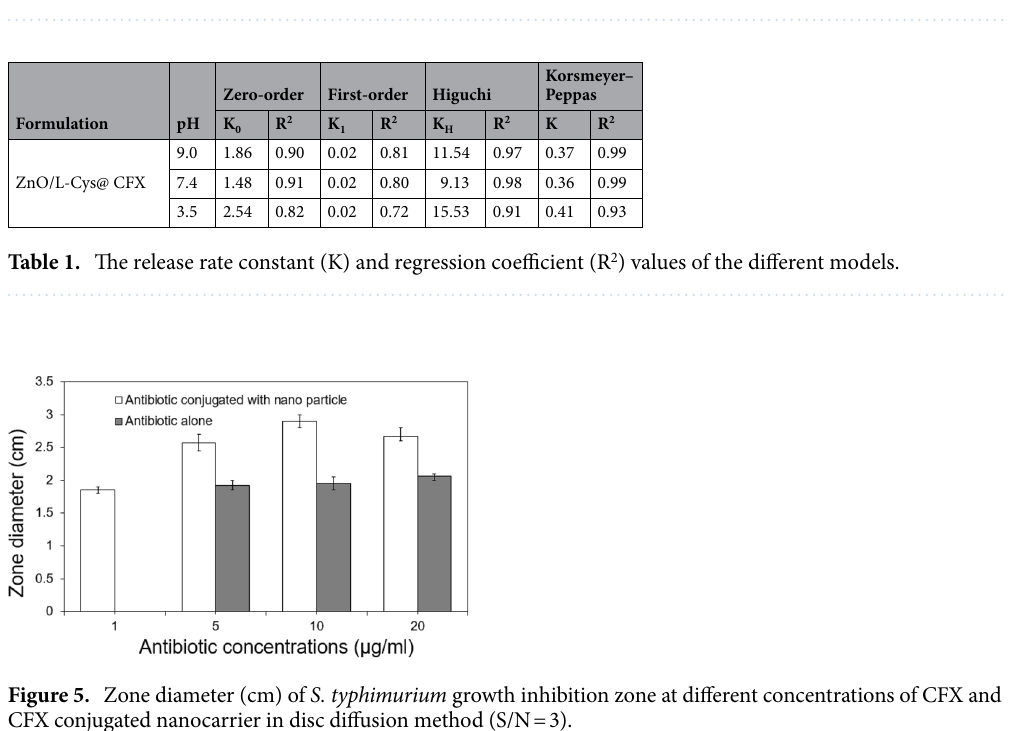
Figure 4. Kinetics model for release of CFX from ZnO/L-Cys@CFX ( A ) zero-order ( B ) first order ( C ) Higuchi and ( D ) Korsmeyer–Peppas model of kinetics.